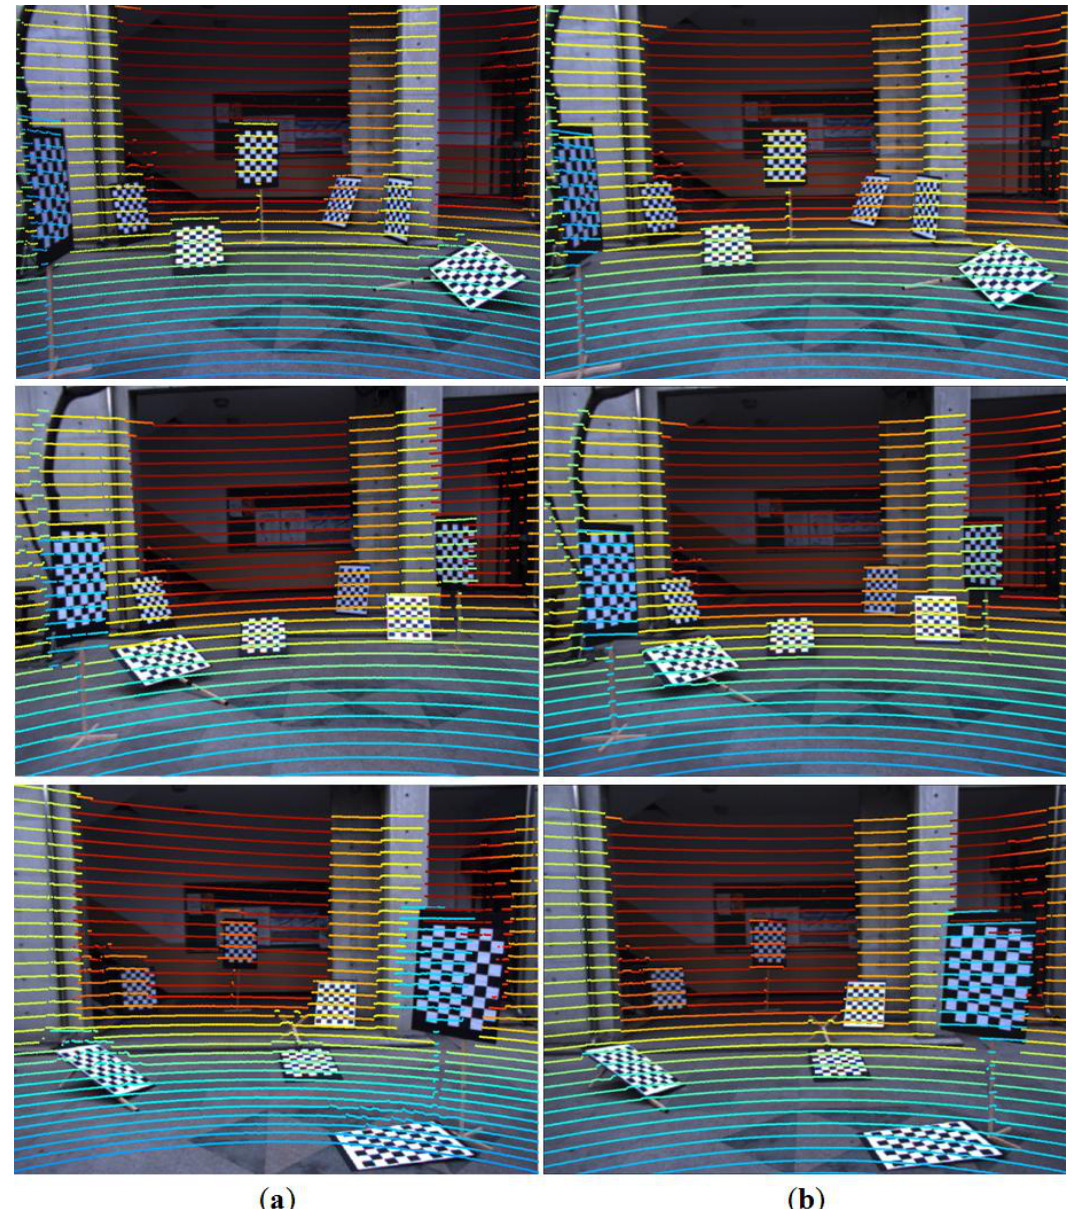
Figure 17. Comparative results: ( a ) Checkerboard method of [15]. ( b ) The projection matrix is estimated by the proposed method; Then, the estimated projection matrix is used to reproject the 3D data of the checkerboard of ( a ) for visual comparison (depths are represented by colors on the scan